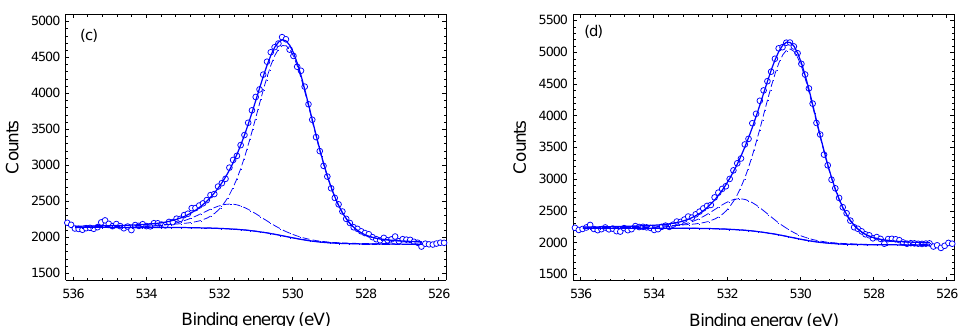
Figure 8. O-1s core level XPS spectra of Ti x -Cu y N z film at different depth: ( a ) at the surface, ( b ) 1 µ m ( c ) 3 µ m and ( d ) 4 µ